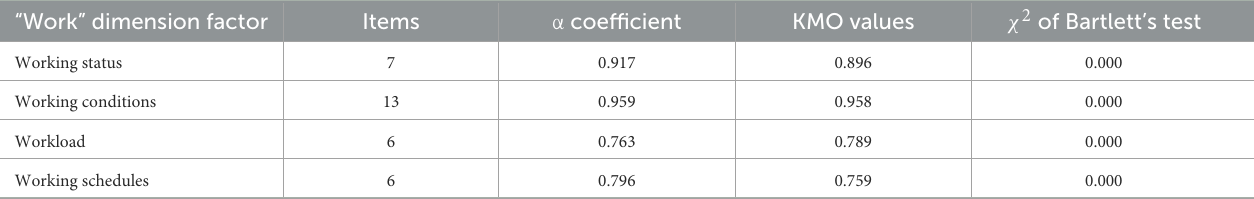
TABLE 2 Reliability and validity test of the questionnaire on factors affecting the fatigue of long-haul flight pilots. “Work” dimension